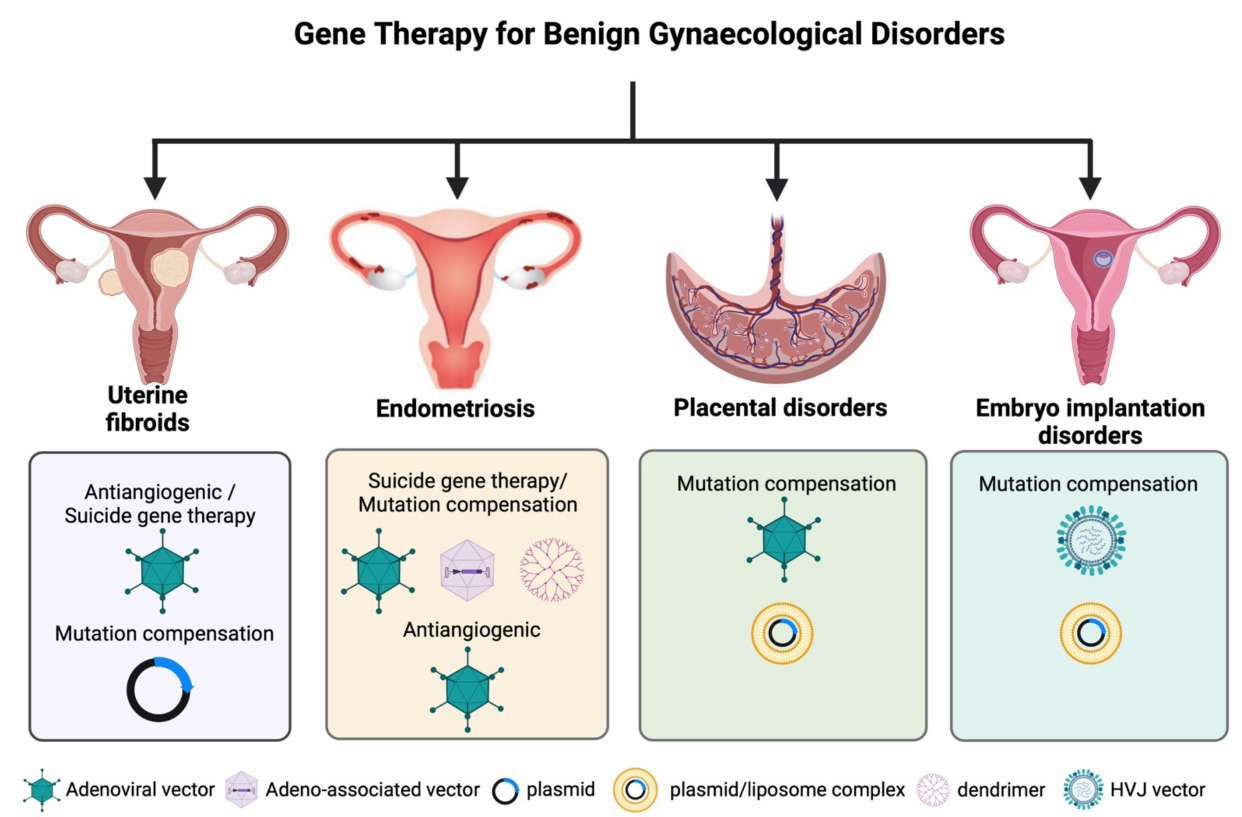
Figure 5. Gene therapy approaches toward benign gynaecological disorders. These include uterine fibroids, endometriosis, placental and embryo implantation disorders, using viral and non-viral systems. Successful approaches against uterine fibroids treatment employed primarily adenoviral vectors and plasmids, for endometriosis adenoviral vectors, adeno-associated vectors, and den- drimers, for placental disorders adenoviral vectors and plasmid/liposome complexes, while for embryo implantation disorders HVJ vectors and plasmid/liposomes